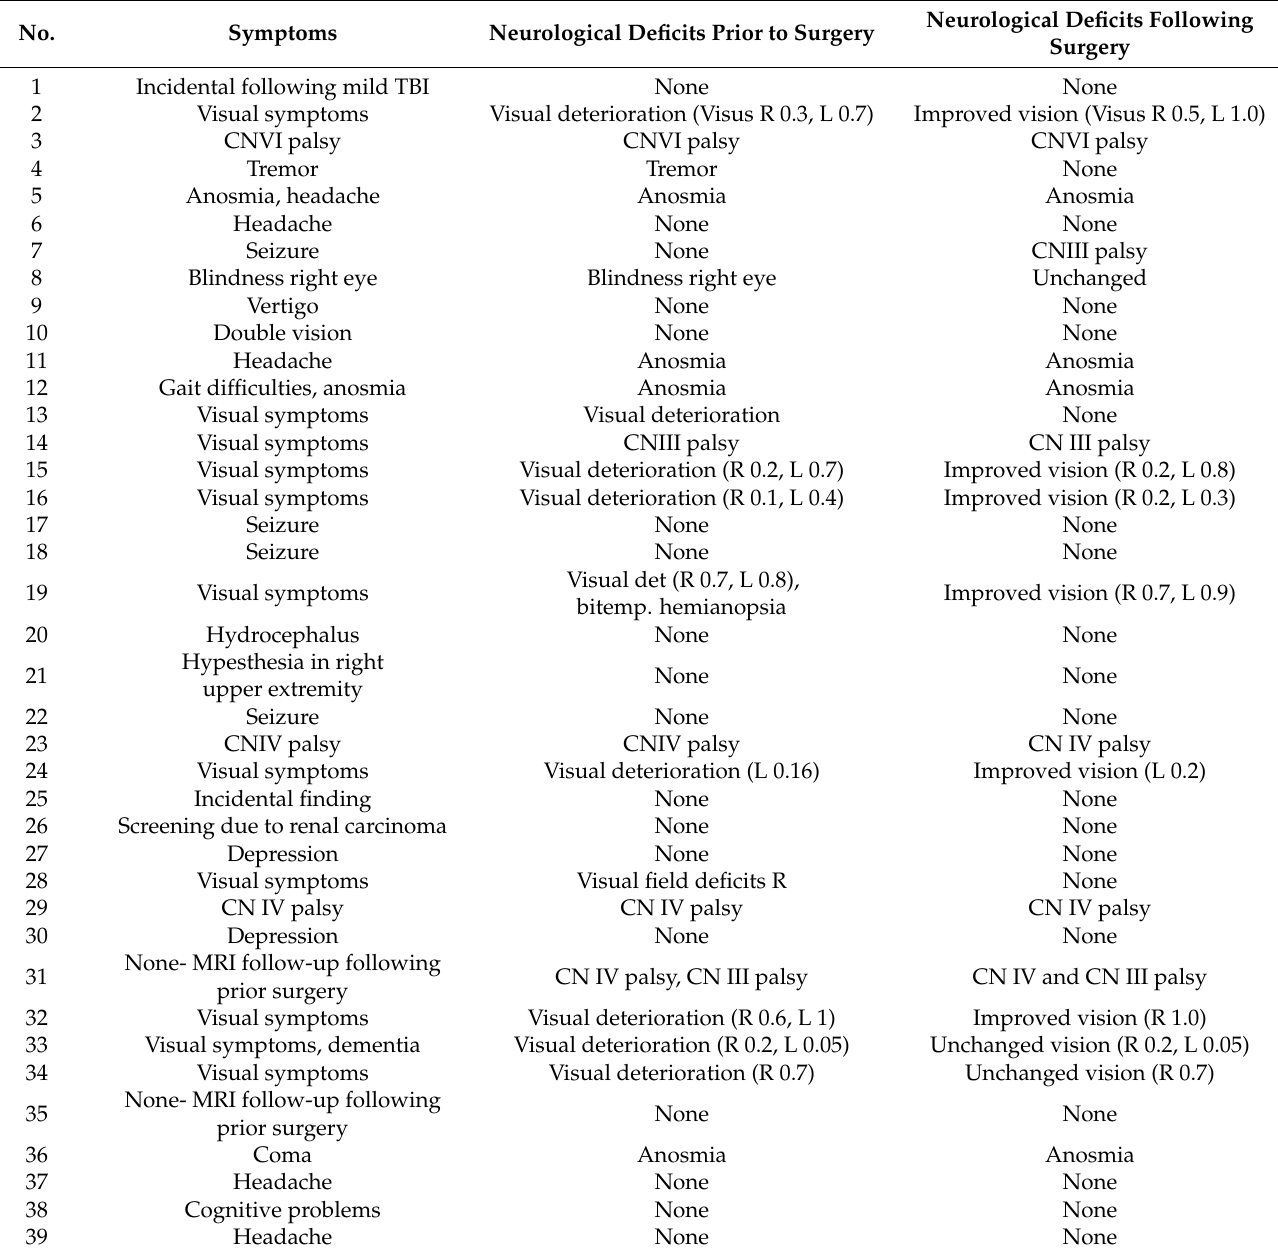
Table legend: CN—cranial nerve, R—right eye, L—left eye, TBI—traumatic brain